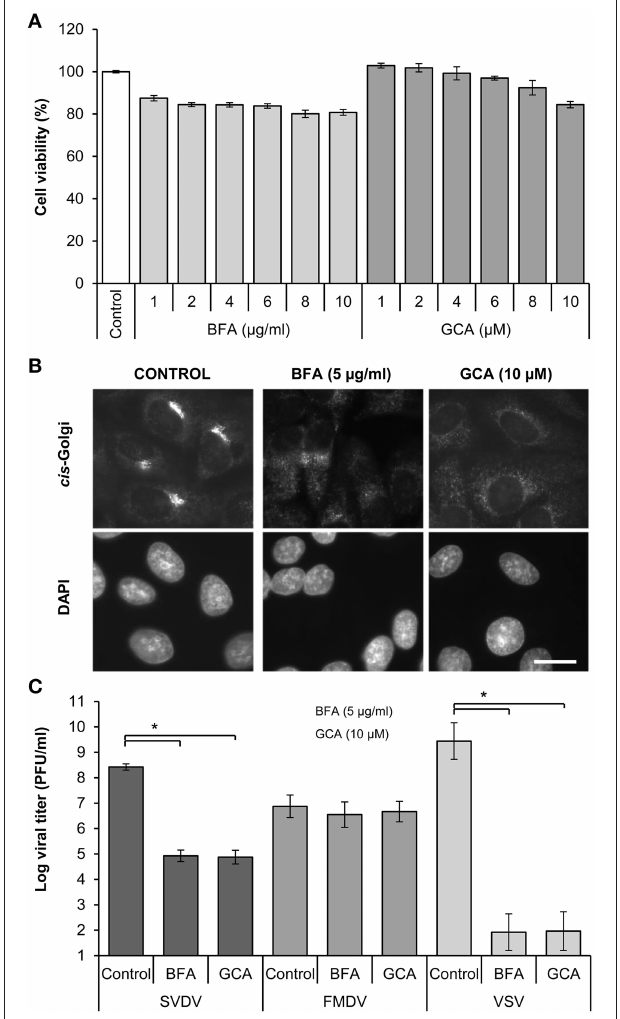
FIGURE 1 | Effect of Golgi disrupting drugs on SVDV, FMDV, and VSV multiplication. (A) Effect of BFA (1, 2, 4, 6, 8, or 10 µ g/ml) and GCA (1, 2, 4, 6, 8, or 10 µ M) on IBRS-2 cell viability determined by ATP measurement. (B) IBRS-2 cells were treated with DMSO (control), BFA (5 µ g/ml) or GCA (10 µ M) for 30 min. Cells were fixed and processed for immunofluorescence using a MAb against the cis -Golgi. Nuclei were stained using DAPI. Bar: 20 µ m. (C) IBRS-2 cells treated as in (B) were infected with the corresponding virus (moi of 0.5 pfu/cell) in presence of the drug. At 8 h pi the viral titer was determined by plaque assay. Error bars represent SD. The data presented correspond to three independent experiments. Data were analyzed using ANOVA. Asterisk ( * ) denote statistically significant differences with P <